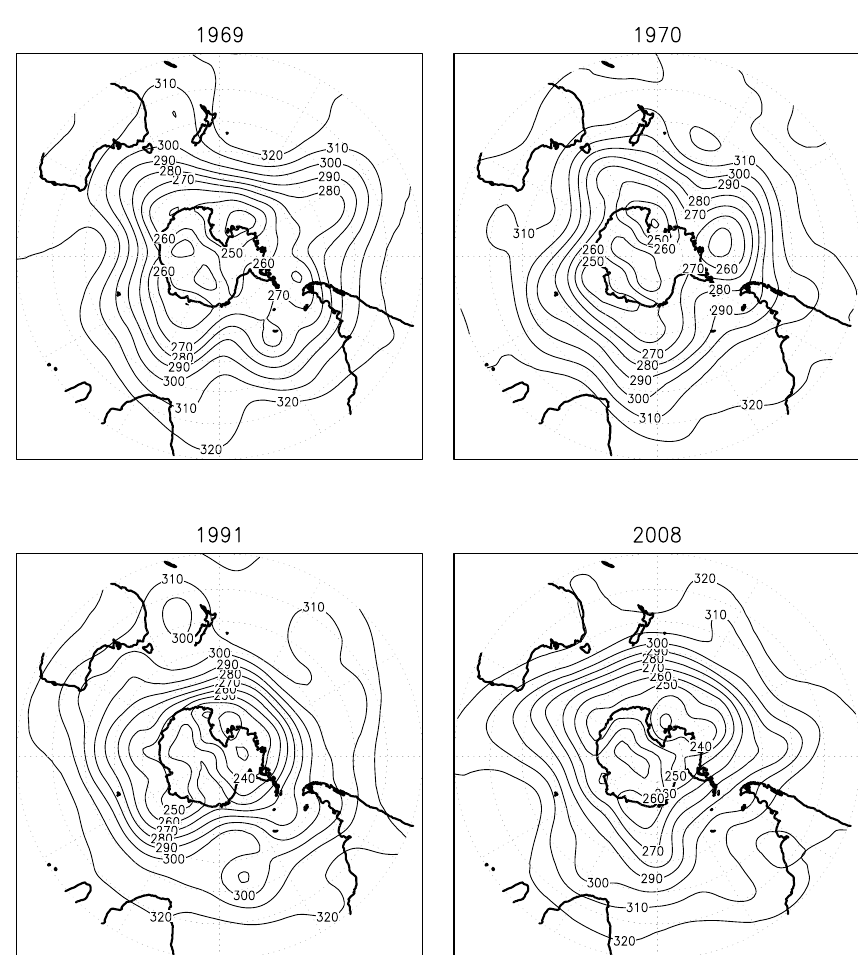
Figure 2. 700hPa geopotential height fields for the top four September inflow events (dates are the same as Fig.